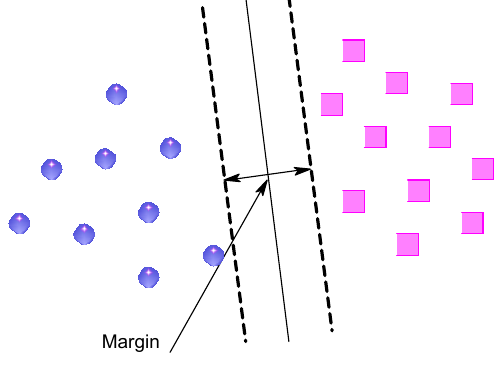
Figure 5. General philosophy of